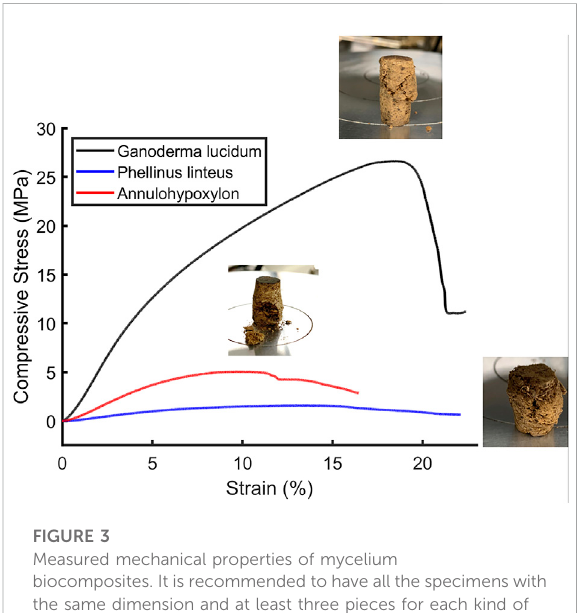
FIGURE 3 Measured mechanical properties of mycelium biocomposites. It is recommended to have all the specimens with the same dimension and at least three pieces for each kind of specimen for more accurate and reliable results in the future.